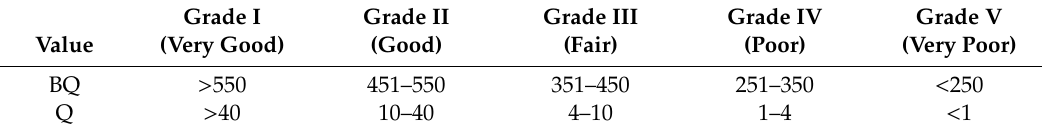
Table 2. Relationship between the basic quality (BQ) system and quality (Q) System.